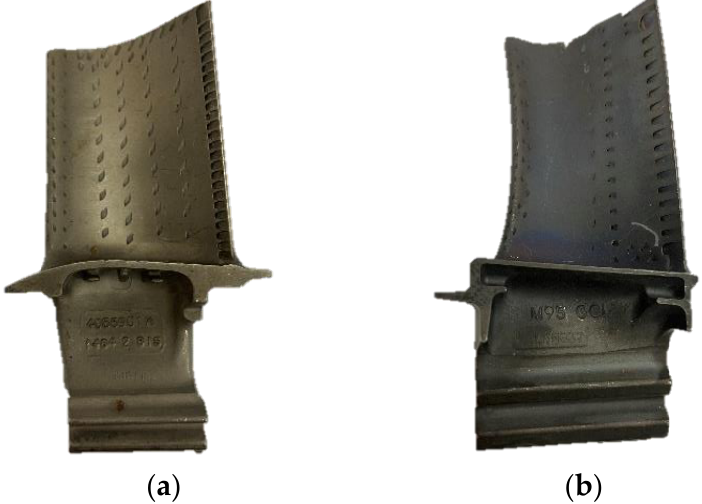
Figure 3. Turbine blades: ( a ) CFM56-7BE aeroengine and ( b ) Pratt & Whitney F100 aeroengine.